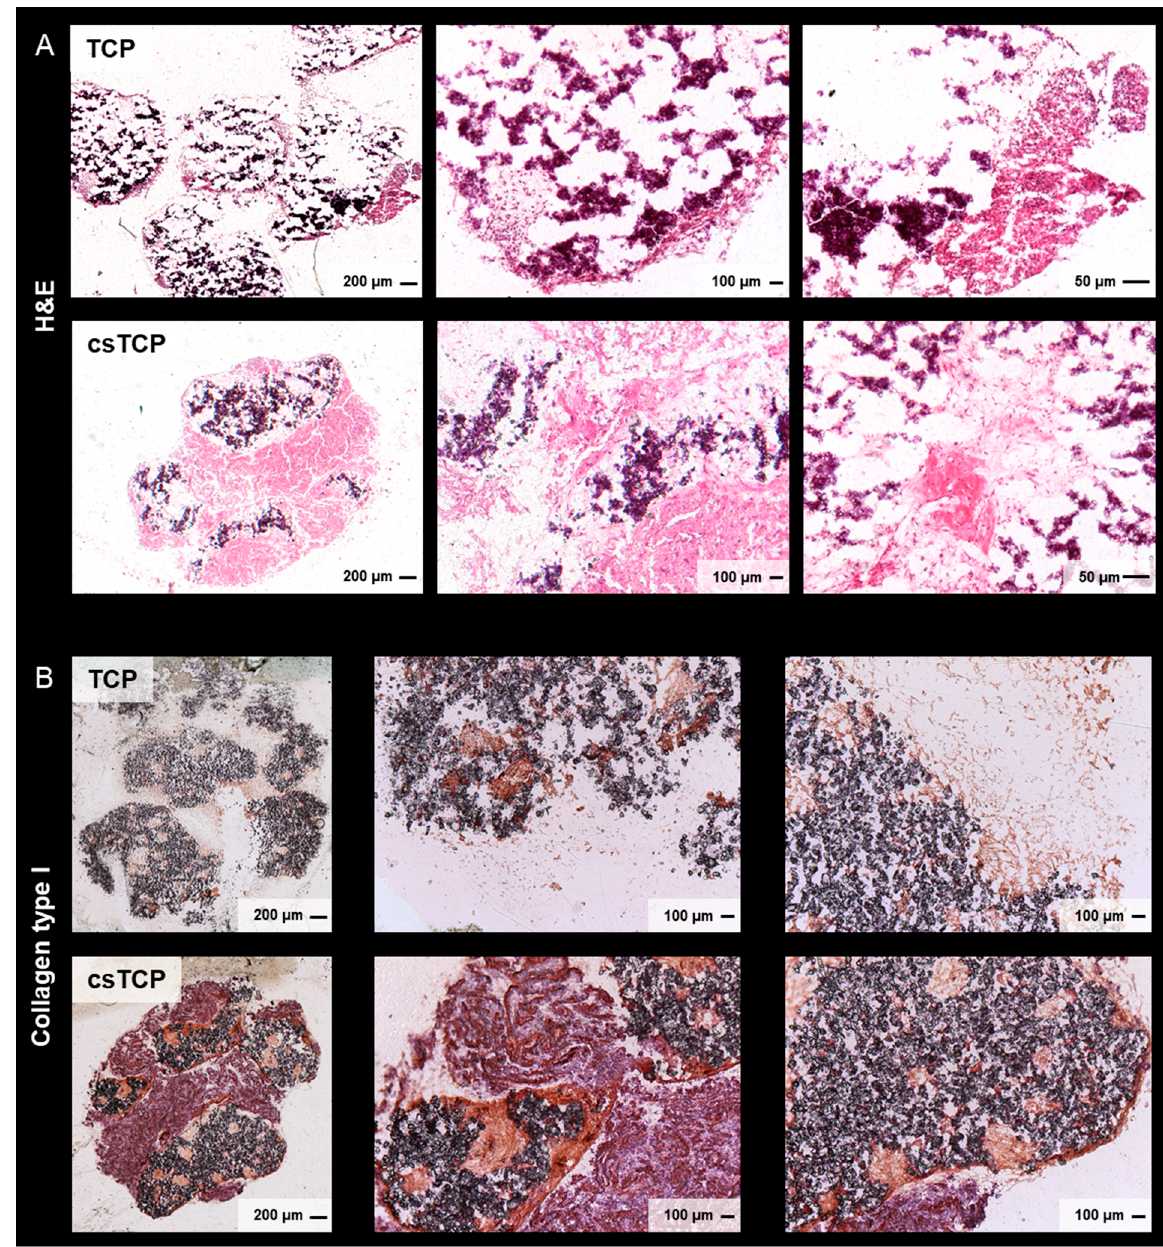
Figure 3. Comparing csTCPs and MSC-populated TCPs regarding uniform cell distribution and ECM at 21 days. ( A ) Representative images of hematoxylin and eosin (H & E) staining. ( B ) Exemplary images of histological sections stained for collagen type I and visualized using brightfield microscopy.